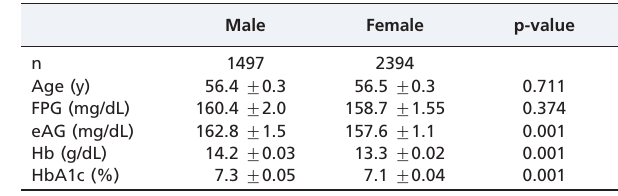
Table 2 - A comparison of the glycemic parameter levels in males and females (mean ¡